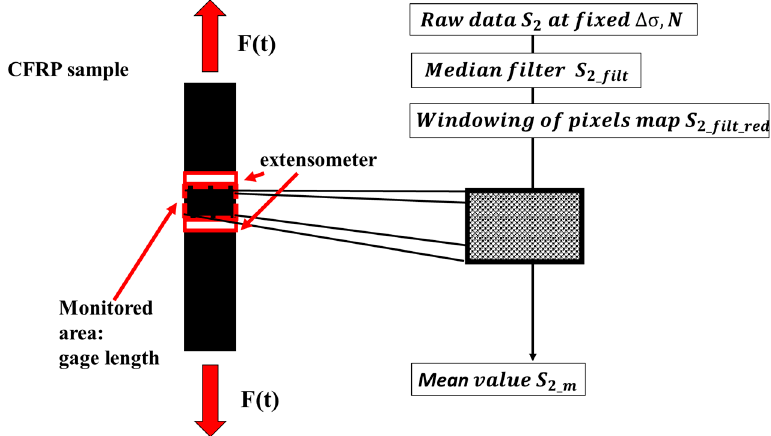
Figure 3. Procedure for processing the second harmonic amplitude of the thermal signal.